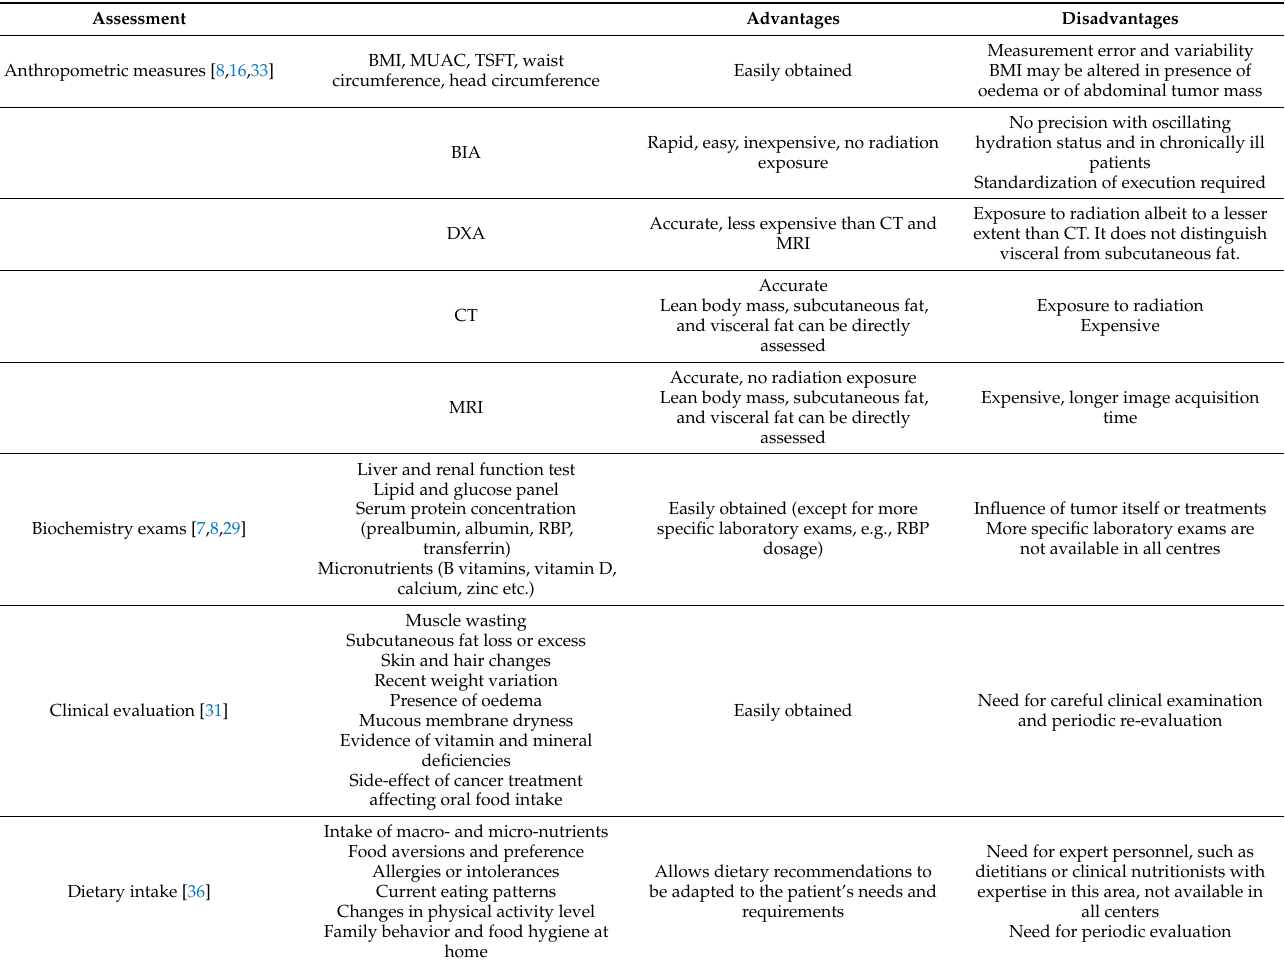
Table 4. Nutritional assessment in children with cancer: the A-B-C-D